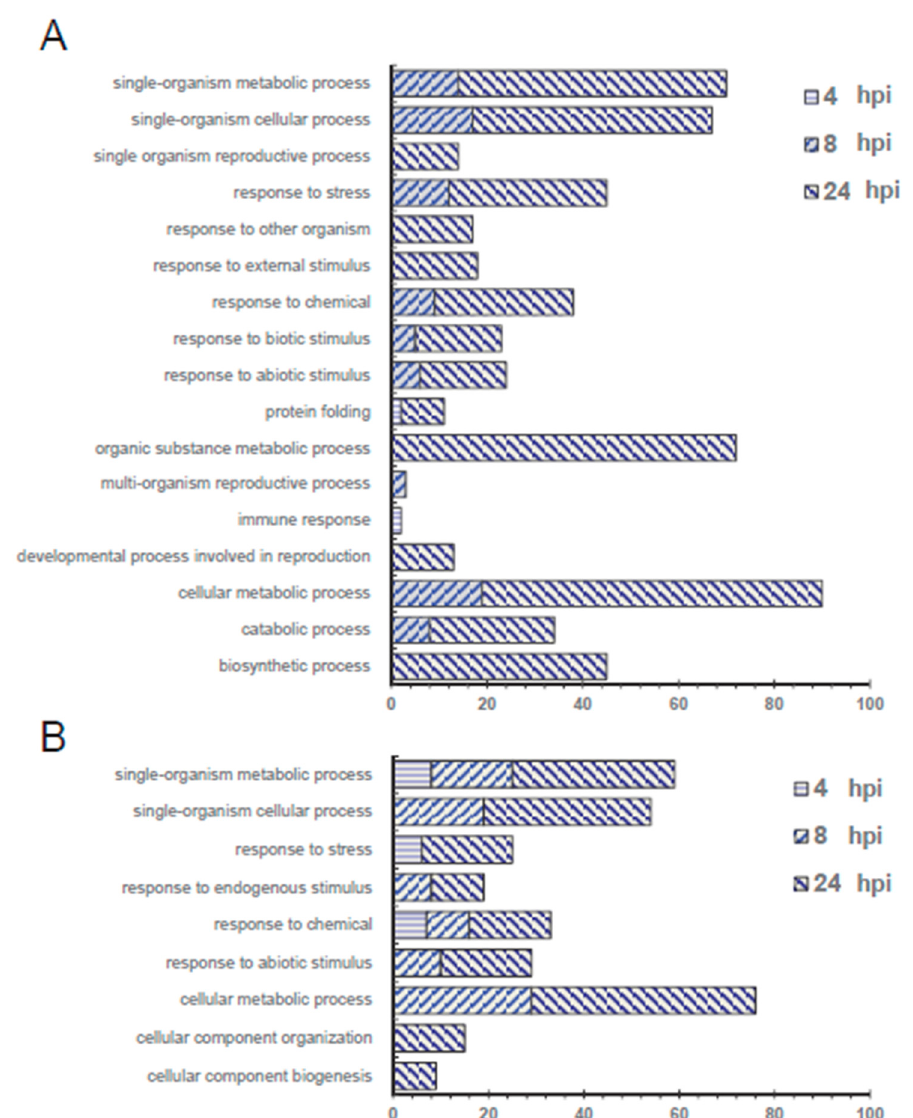
Figure 3. Biological process function analysis for tomato leaf proteins with a ( A ) significant increase or ( B ) decrease in quantity at different infection time points, 4, 8 or 24 hpi compared to the mock group. Only proteins with fold change greater than 1.5 or less than 0.67 ( p < 0.05) were analysed and used for searching the Arabidopsis homolog proteins by Protein Basic Local Alignment Search Tool (BLASTP) against the Arabidopsis Information Resource (TAIR) database. Gene Ontology (GO) categorization of these Arabidopsis homolog proteins was performed by using the Database for Annotation, Visualization and Integrated Discovery (DAVID) v6.8.